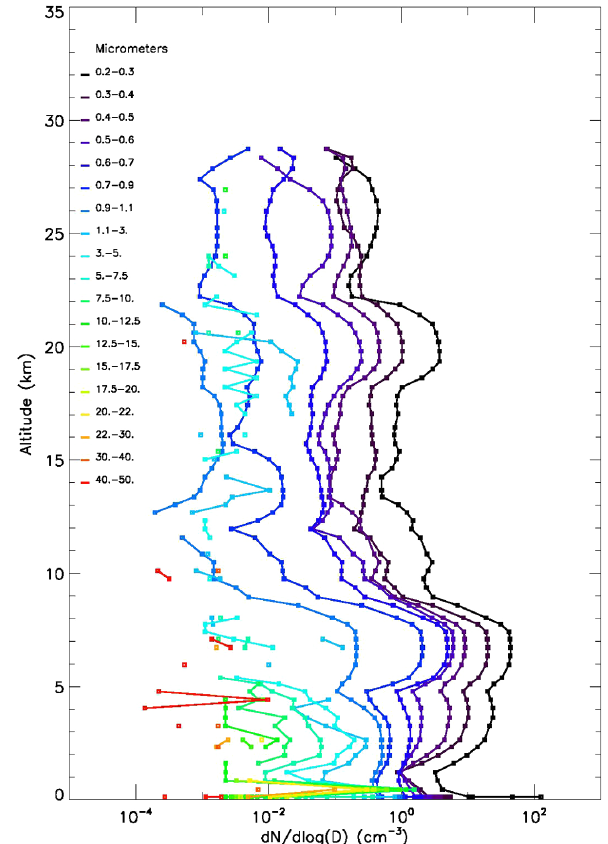
Figure 17. LOAC flight under a meteorological balloon from Aire-sur-l’Adour (France) on 12 August 2015 between 9:50 and 11:40UT during the VOLTAIRE-LOAC campaign; the uncer- tainty (at 1 σ ) is of about ± 20% for concentrations higher than 10 − 1 cm − 3 up to ± 60% for concentrations lower than 10 − 2 cm − 3 . The stratospheric aerosol content is low, since no major volcanic eruption has occurred